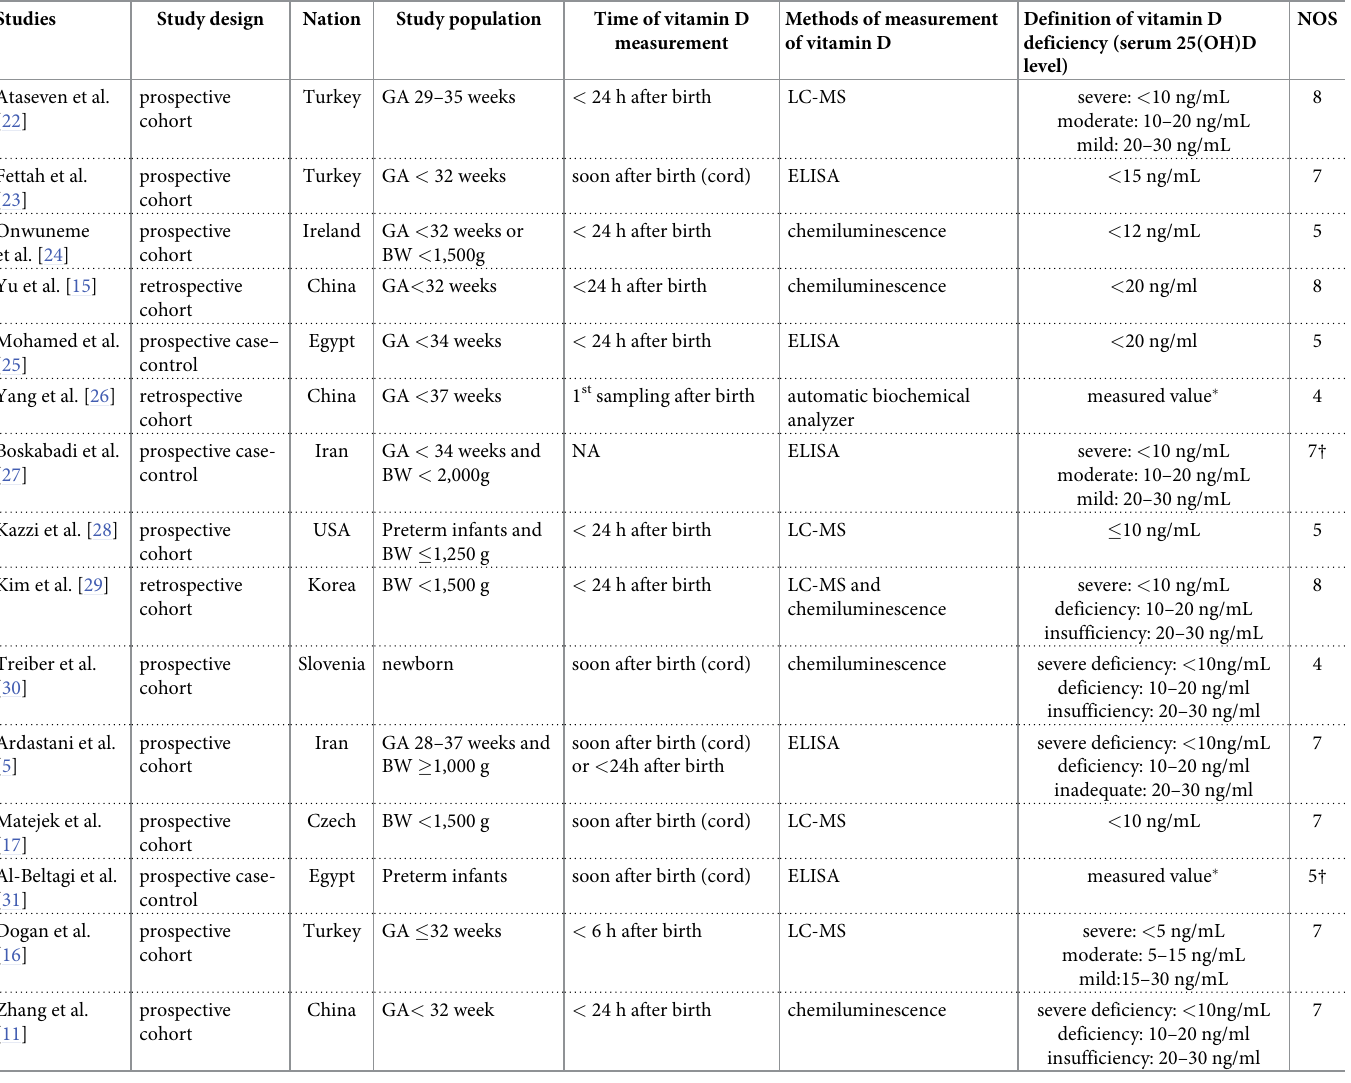
Table 1. Characteristics of studies included in the